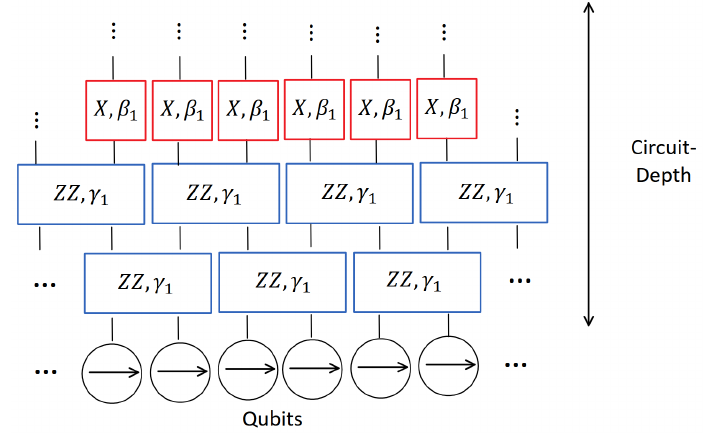
Figure 2: Quantum circuit realization of the VQCS protocol on a digital quantum sim- ulator. Shown is the first layer of the protocol (5) using angles ( γ to time evolution by two-site and one-site gates Z quent layers utilize different angles ( γ VQCS , the quantum circuit has a depth of at most 3 p p